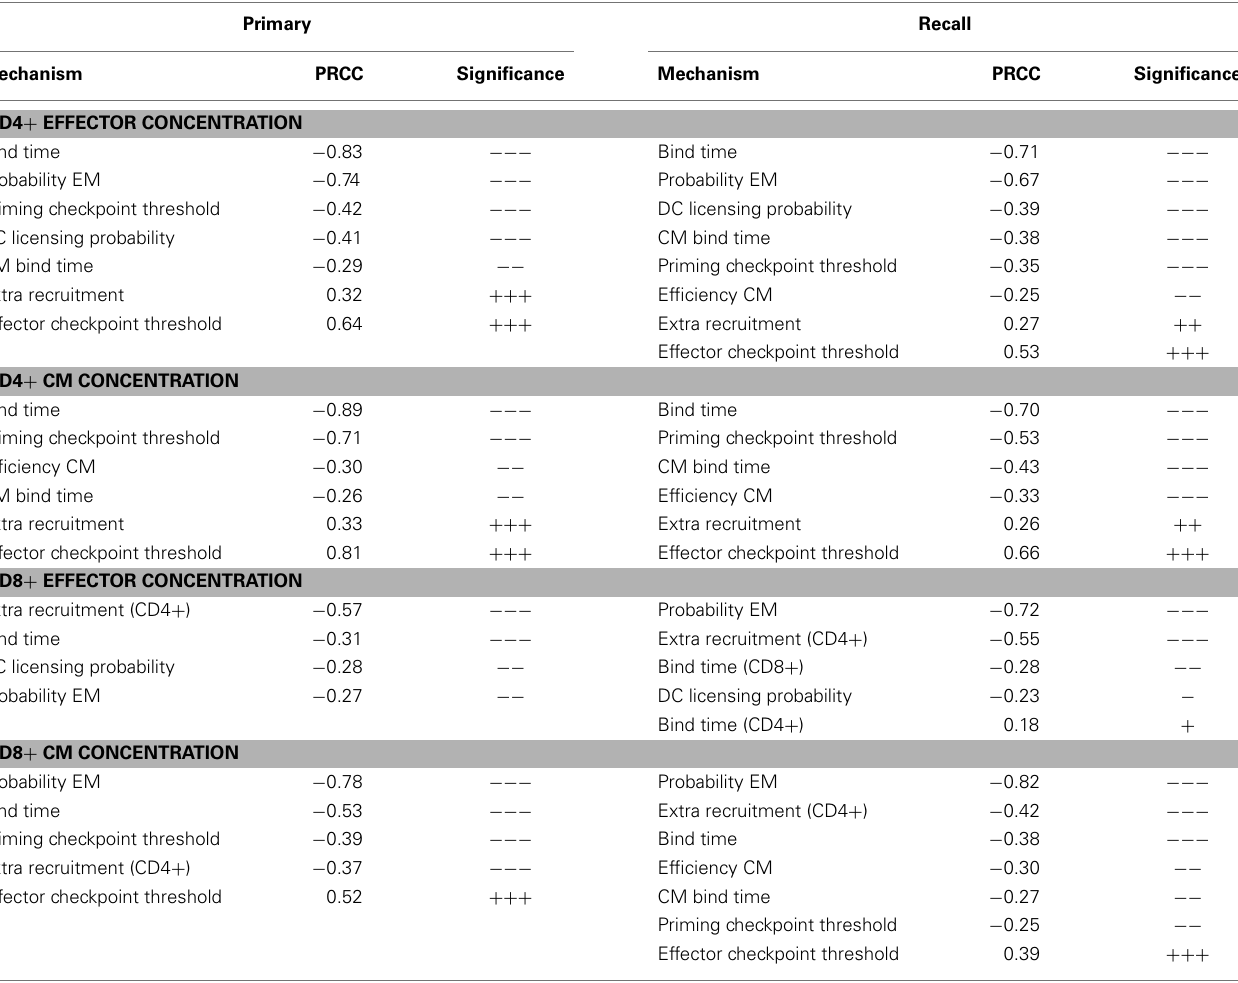
Table 2 | PRCC results: tracking sensitivity of concentrations of cells in Blood to LN mechanisms.